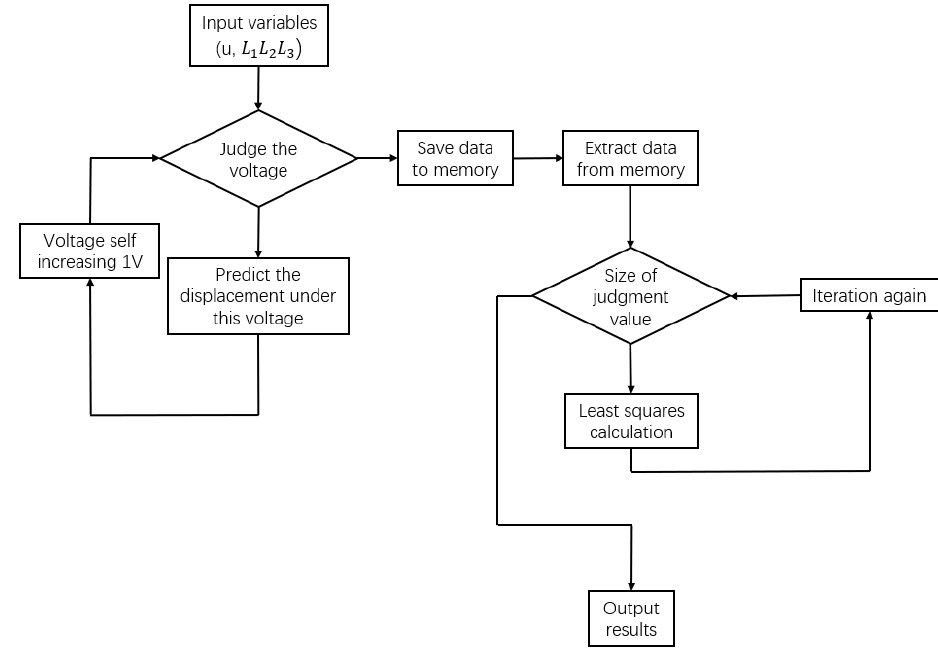
Figure 4. Flow Chart of IFEA Algorithm.